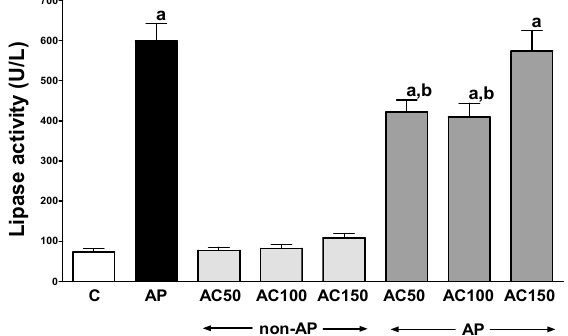
Figure 6. Impact of pretreatment with acenocoumarol on serum activity of lipase in rats with or without cerulein-induced pancreatitis. Key: C = control; AP = cerulein-induced acute pancreatitis; non-AP = groups without induction of acute pancreatitis; AC = acenocoumarol; 50 = 50 µg/kg/day; 100 = 100 µg/kg/day; 150 = 150 µg/kg/day. Mean ± SEM. n = 10 in each group of rats. a p < 0.05 compared to control; b p < 0.05 compared to AP alone.